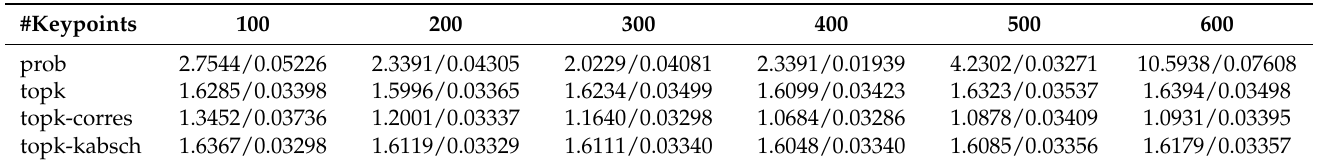
Table 1. Mean absolute error of rotation ( ◦ ) and translation from different estimators with various number of